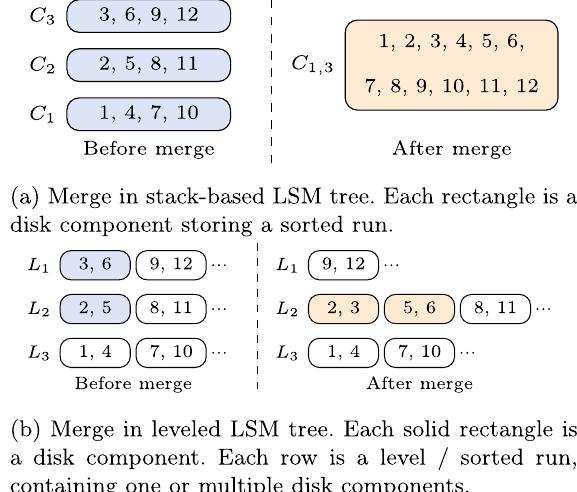
Fig. 3 Examples of merges in stack-based and leveled LSM trees. Input and output components in a merge are marked in blue and orange, respectively. Keys in a component are represented by the numbers inside the rectangle